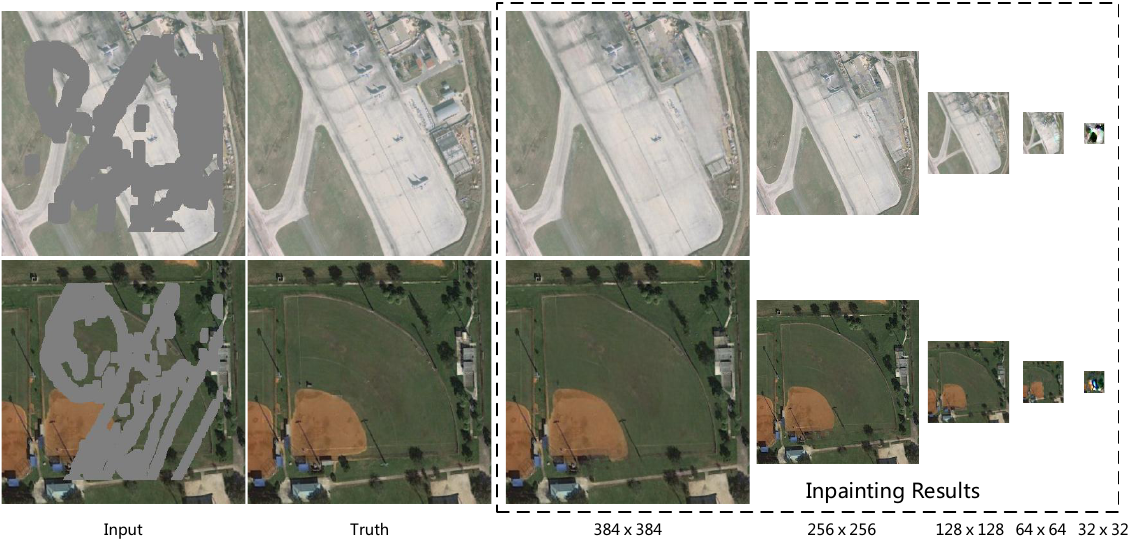
Figure 13. Inpainting results for different resolutions on the AID dataset. Please zoom in for